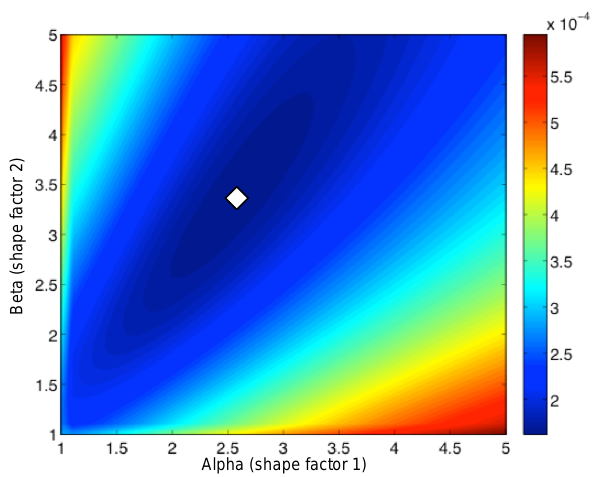
Figure 8. Objective function for best-fit beta distribution shape pa- rameters. Contour plot of root mean sum of squared error (RMSE) between actual and predicted area density of elevation for a given travel distance for paired values of beta distribution shape param- eters. Minimum RMSE at α = 2 . 6 and β = 3 . 4 as indicated by the diamond. In this example, travel distance and elevation bin sizes equal 100 and 40m, respectively.